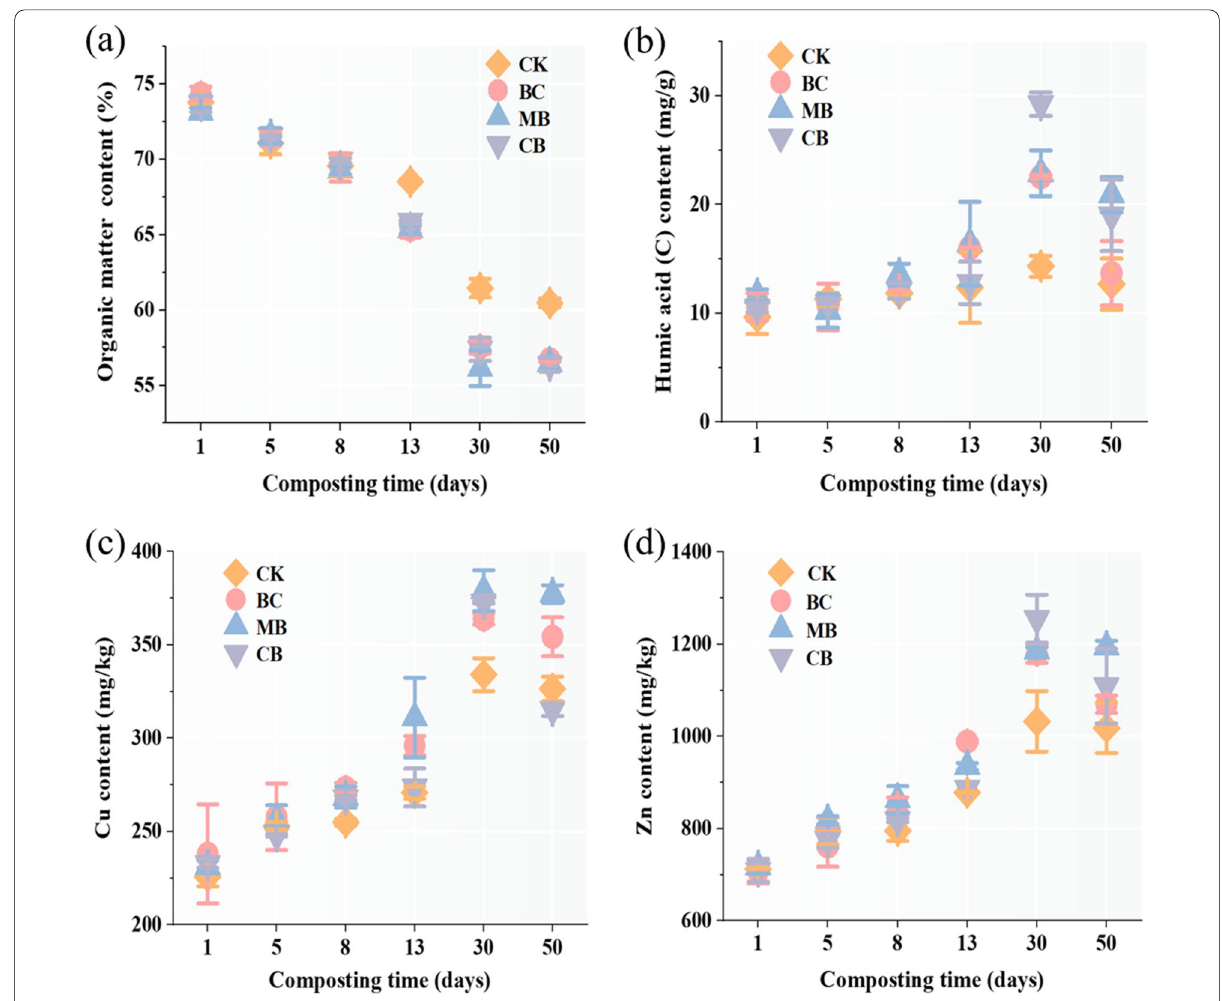
Fig. 1 Changes of physicochemical indexes and heavy metal content during composting. a Organic matters content; b humic acid content; c Cu content; d Zn content. CK CK composting, BC BC composting, MB MB composting, CB CB